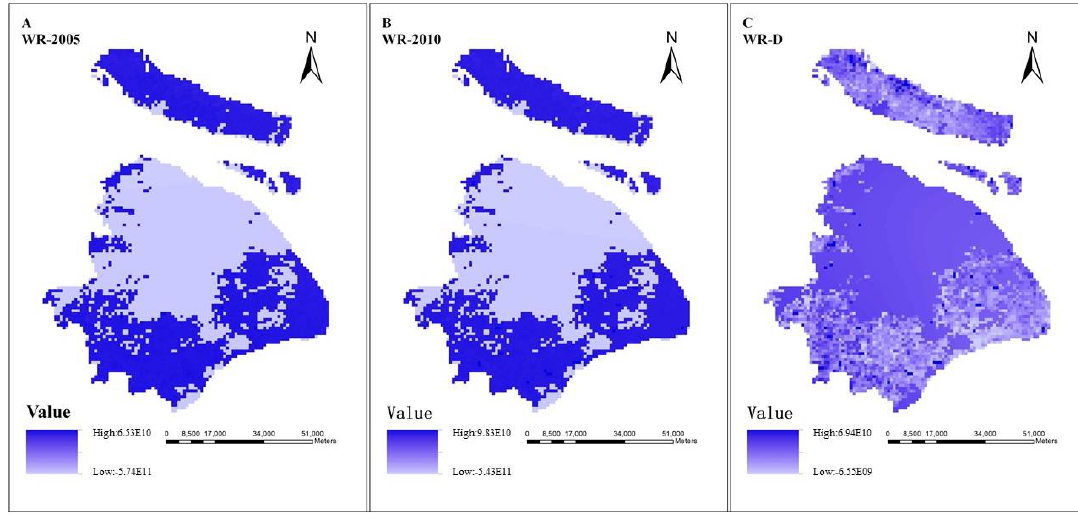
Figure 9. Spatial and temporal change of water retention service in Shanghai (sej/yr). ( A ) spatial